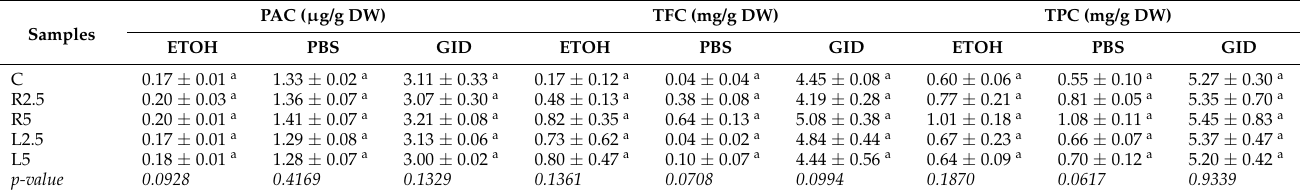
Table 1. Phenolic compound content in pasta supplemented with dried Reishi and Lion’s Mane